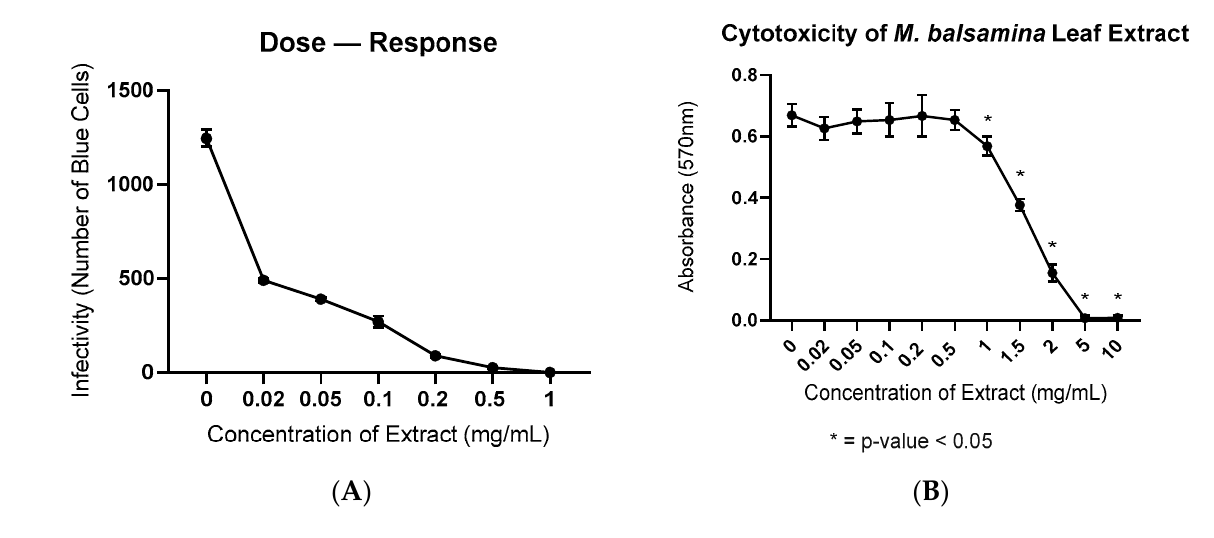
Figure 1. ( A ) This is a dose–response curve measuring the viral inhibition of the M. balsamina leaf extract against 1 ng of NL4-3. Treatment concentrations range from 0–1 mg/mL of extract. This assay was done in triplicate with the average infectivity for each concentration shown; ( B ) MTT assay. Concentrations of M. balsamina extract tested for cytotoxicity ranged from 0–10 mg/mL. The assay was done in triplicate.